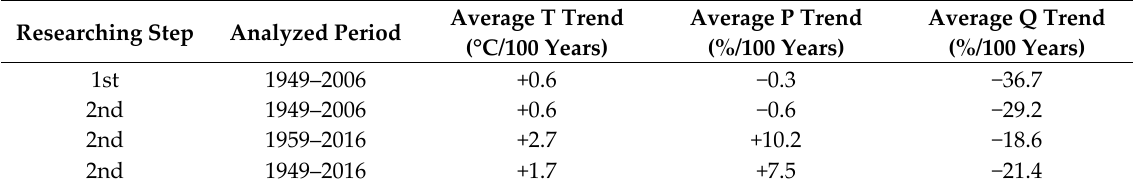
Table 6. Dependence of average T, P and Q trends from the selected